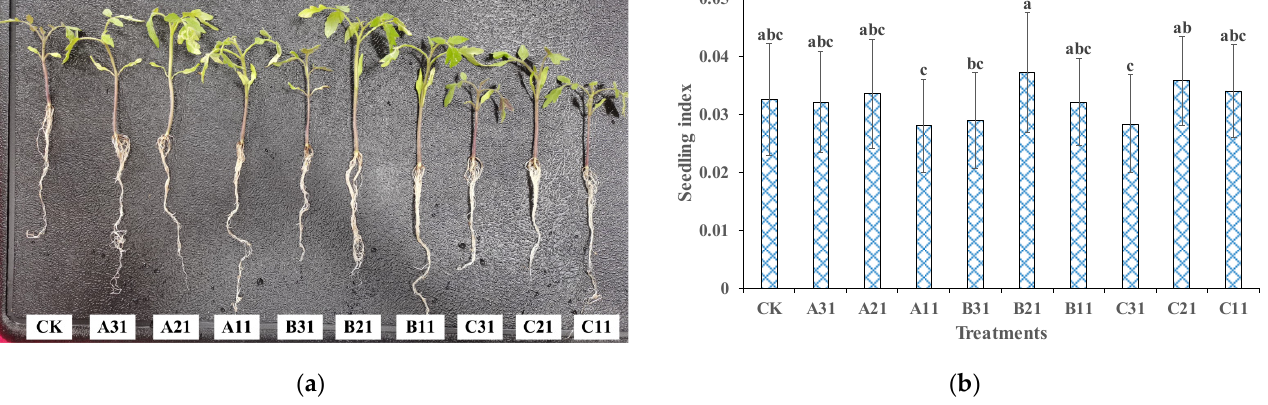
Figure 3. Growth characteristics of tomato seedlings raised in different substrates: ( a ) growth morphology of tomato seedling; ( b ) seedling index: the same letters indicate no significant difference at p < 0.05 level by Duncan’s multiple comparison method.